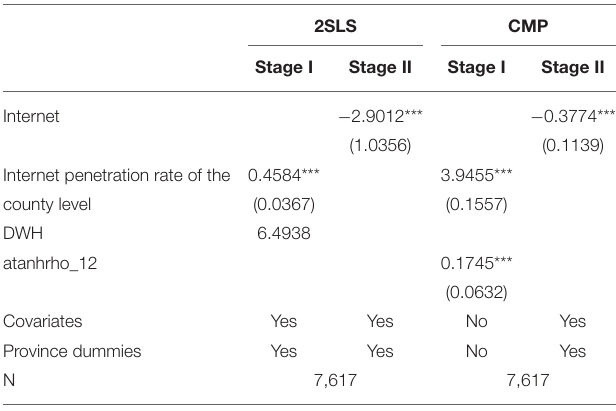
TABLE 4 | Results Estimated by the 2SLS and CMP Methods.